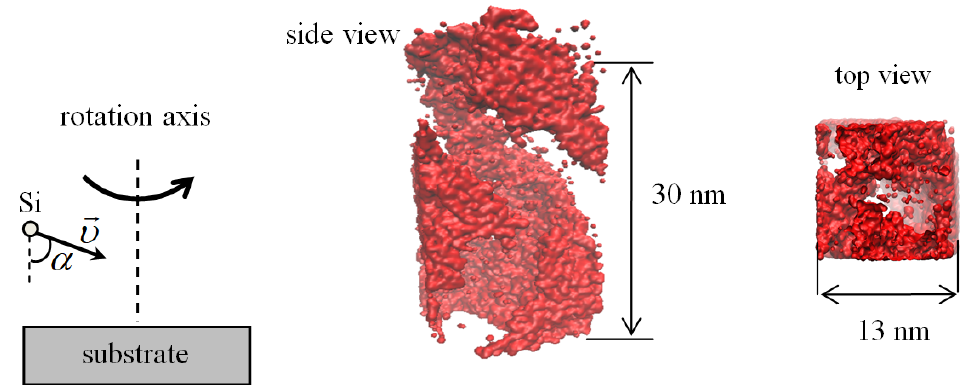
Figure 5. The helical structure growing under slow substrate rotation speed. The free volume inside the deposited films is painted in red.